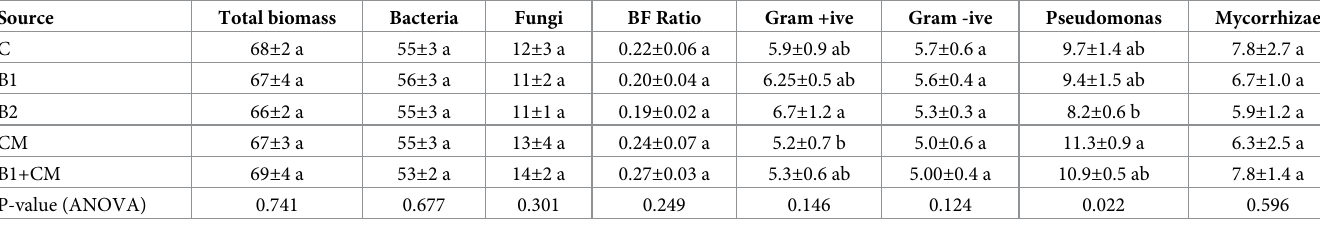
Table 3. PLFA-based profiles of soil microbial community under biochar and compost